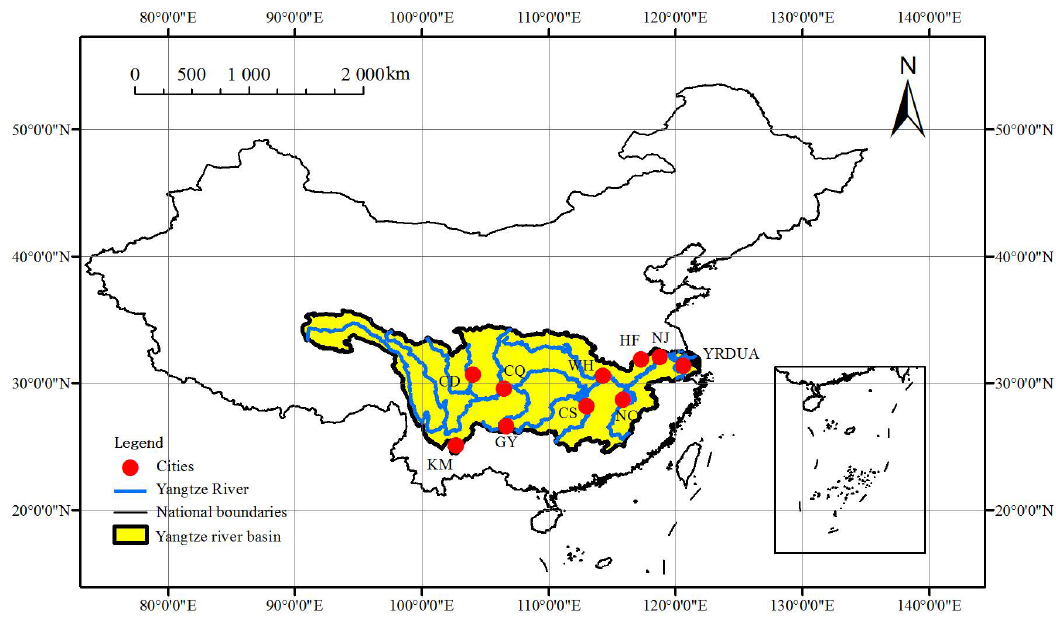
Figure 1. The spatial distributions of the 10 cities in Yangtze River Basin, China, including Chengdu (CD), Kunming (KM), Guiyang (GY), Chongqing (CQ), Wuhan (WH), Changsha (CS), Nanchang (NC), Hefei (HF), Nanjing (NJ) and Yangtze River Delta Urban Agglomeration (YRDUA). The index map is South China Sea, and the map projection system is Xi’an